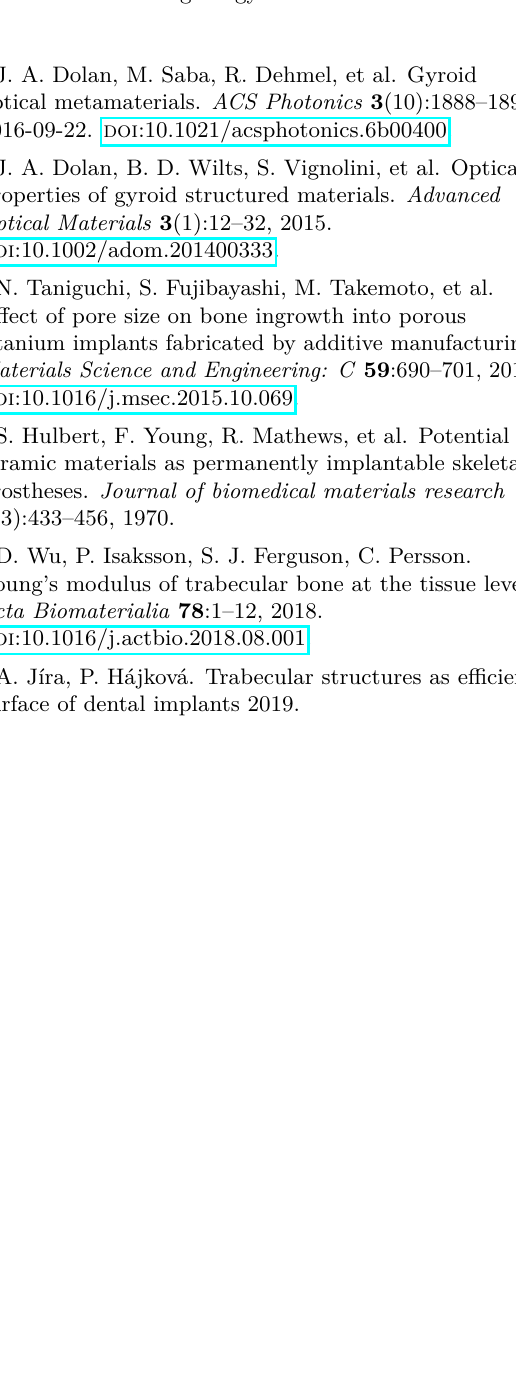
Table 2. Mean values of the mechanical properties for each of the designed gyroid